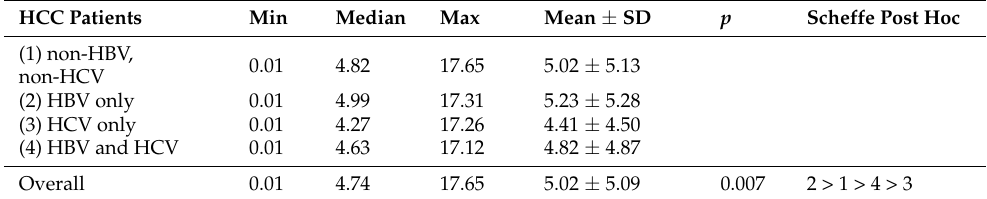
Table 4. Years to